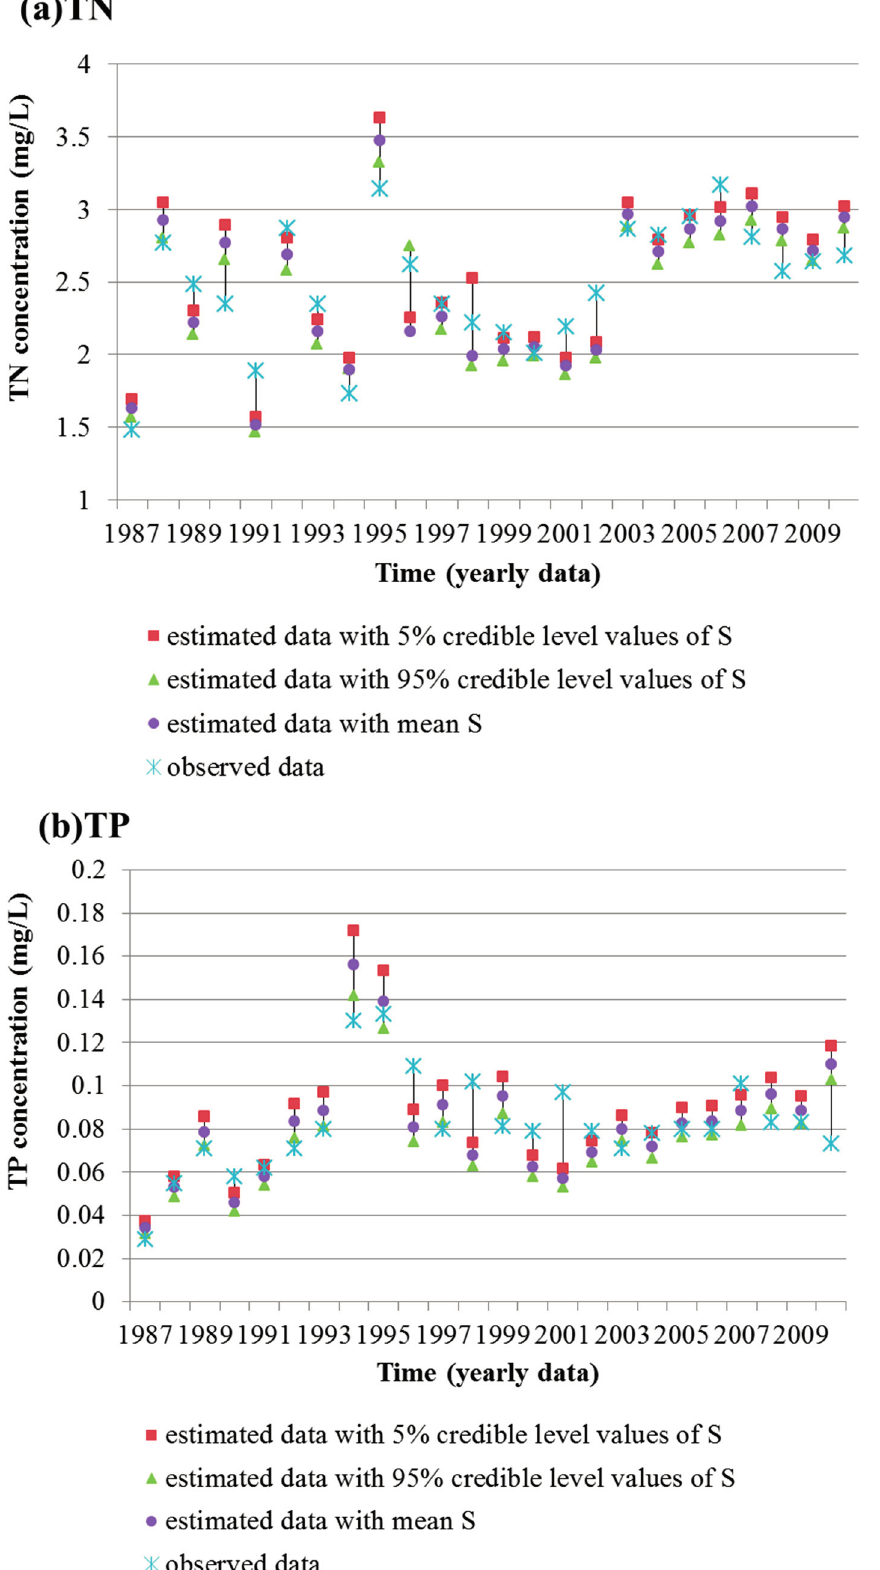
Figure 1. Model fitting results for TN ( a ) and TP ( b ) between observed data and simulated data with mean S , 5% and 95% credible level values of S